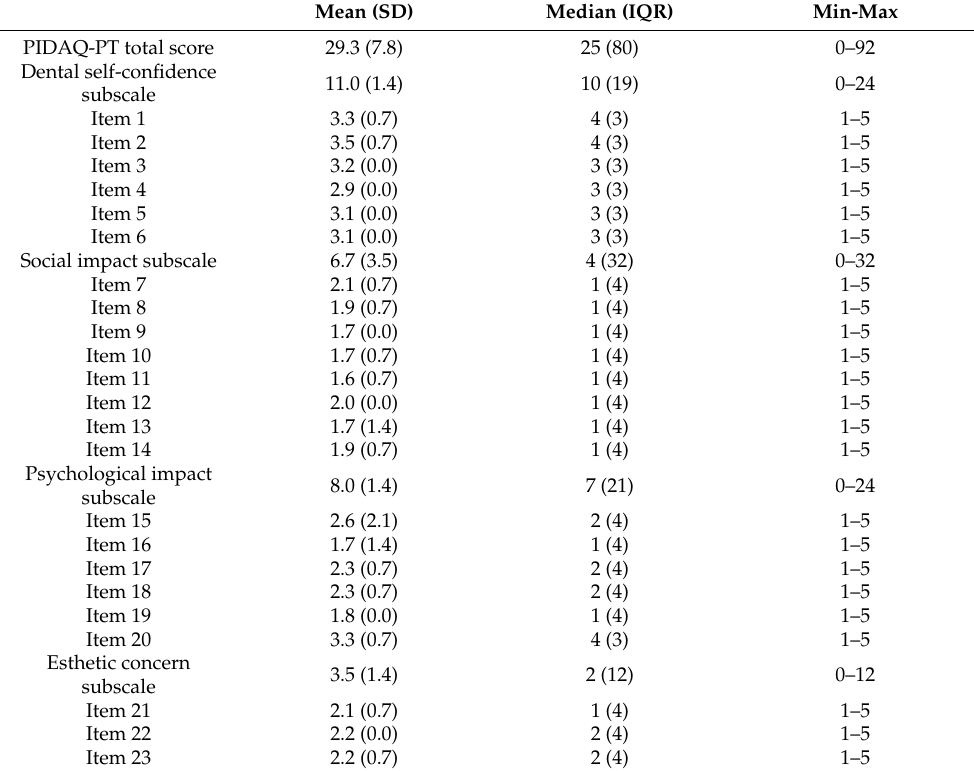
Table 2. Descriptive statistics of the PIDAQ scores (mean and standard deviation (SD), median and interquartile range (IQR), minimum and